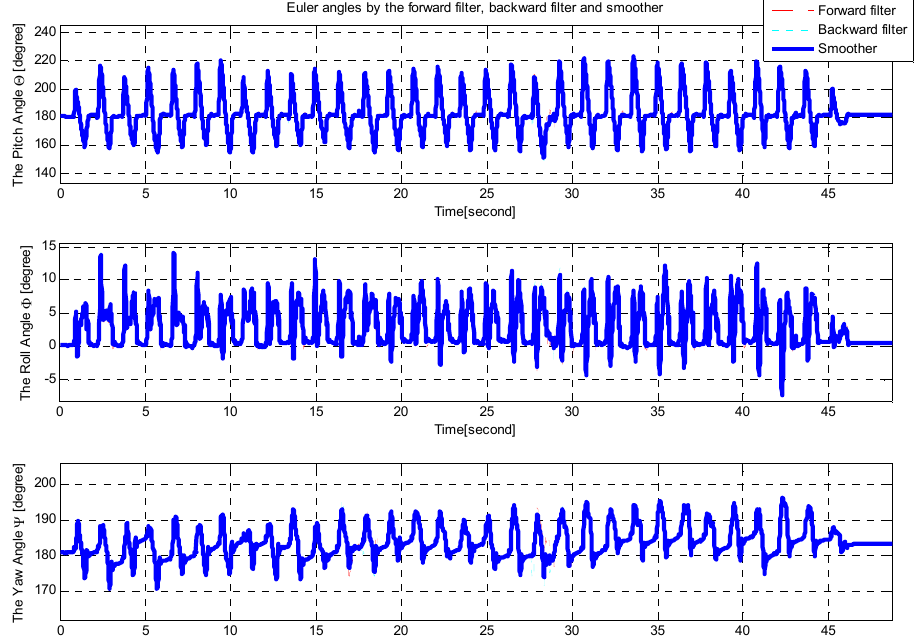
Figure 8. Floor experiment (Euler angles